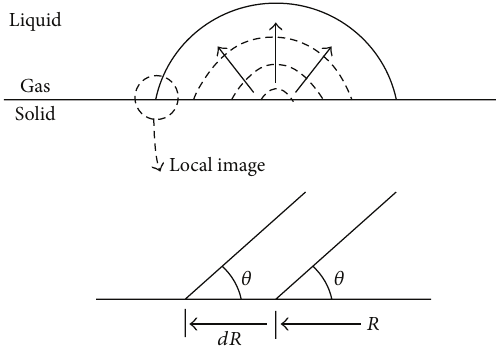
Figure 1: Mathematical image of the